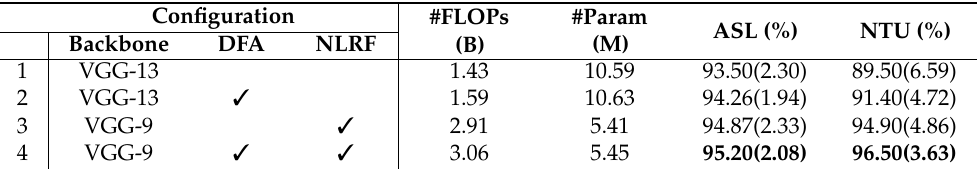
Table 3. Ablation study for various configurations of RFaNet on the ASL and NTU datasets in terms of accuracy (%). Notably, the VGG-13 has four more convolutional layers than the VGG-9. These four convolutional layers were inserted before the global average pooling layer. Numbers in parentheses indicate the standard deviation. #FLOPs: number of floating-point operations; #Param: number of parameters of a model. Bold values indicate the highest classification accuracy among the four configurations.